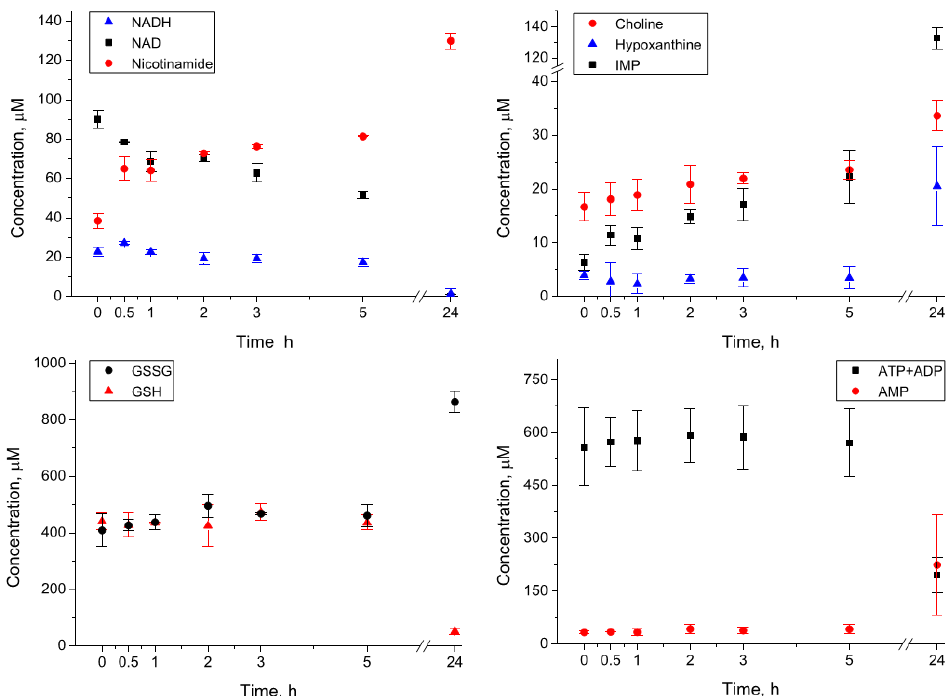
Figure 1. Kinetics of metabolite concentrations in the whole blood homogenates during the incubation at 4 ◦ C. Table 2. Concentrations of metabolites (in units of nmol/g) in extracts and homogenates of the rat brain at zero time and after 24 h of incubation at 4 ◦